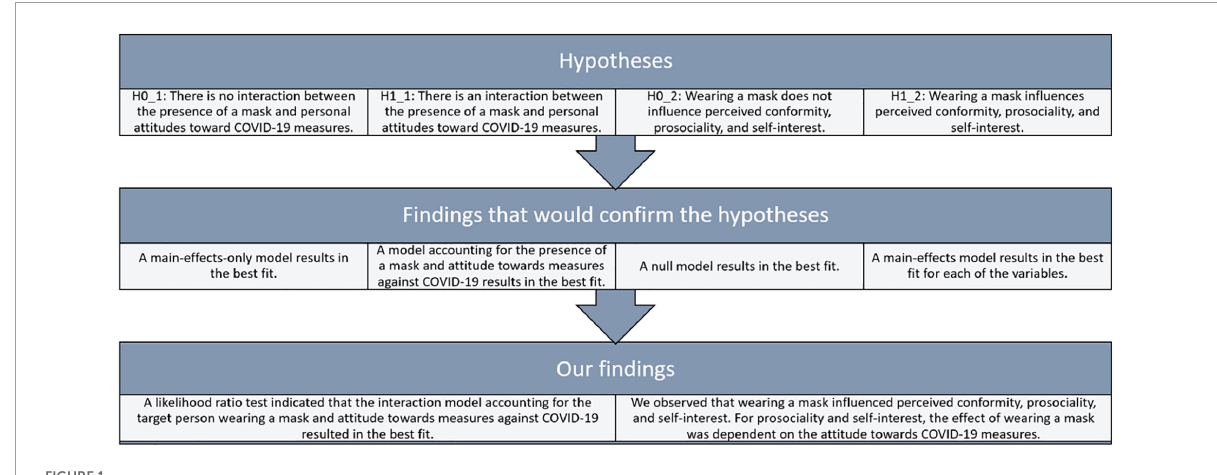
FIGURE1 Hypotheses, predicted observations, and findings for experiment 1.